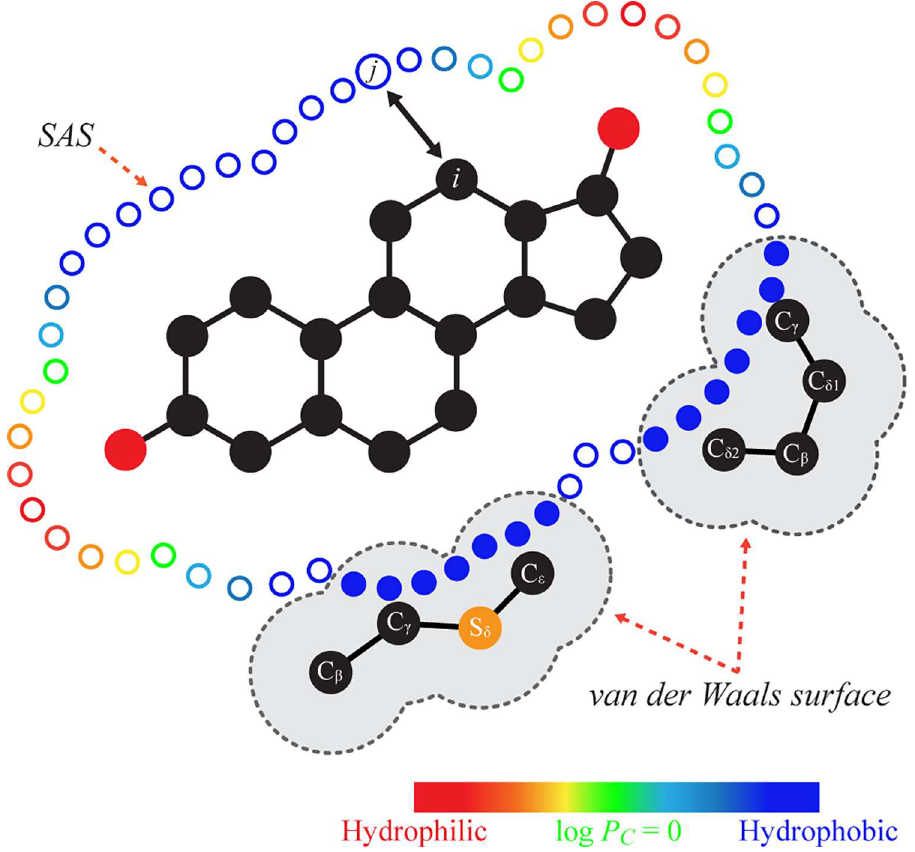
Fig 1. Description of hydrophobic interactions on the contact surface. Hydrophobic and hydrophilicgrid points are representedby blue and red circles, respectively, on the SAS of the ligand. Hydrophobic grid points within the van der Waals surface of hydrophobic residues are marked by filled blue